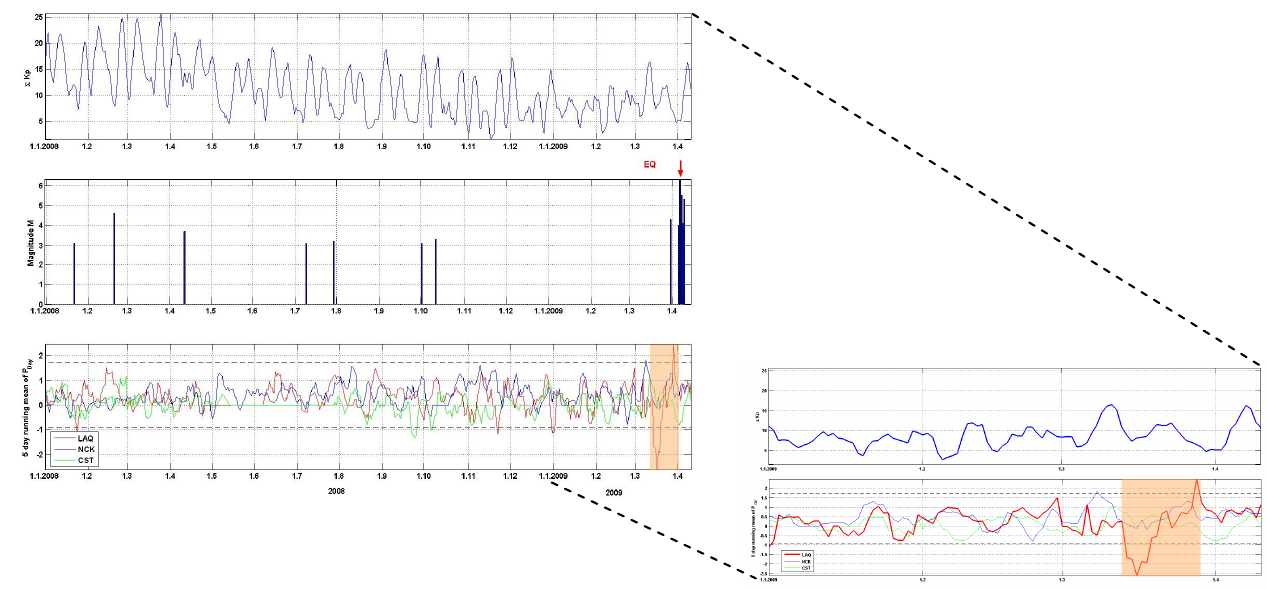
Fig. 1. Long term and zoomed for the LAQ EQ series polarization station